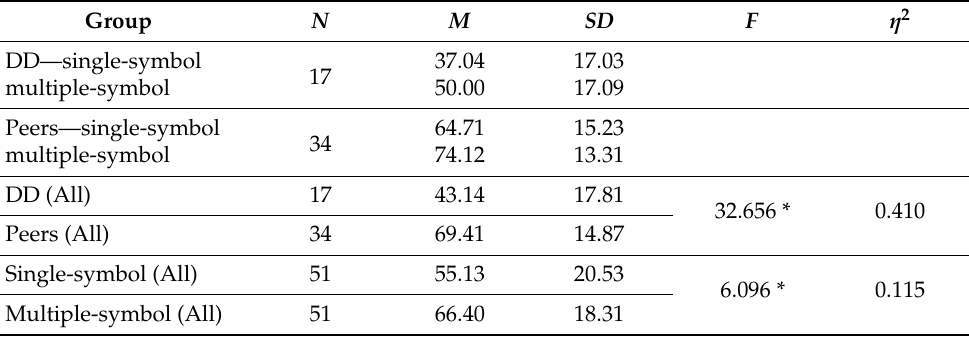
Table 4. Success rates of PCS identification for children with and without developmental delays (DD) (by